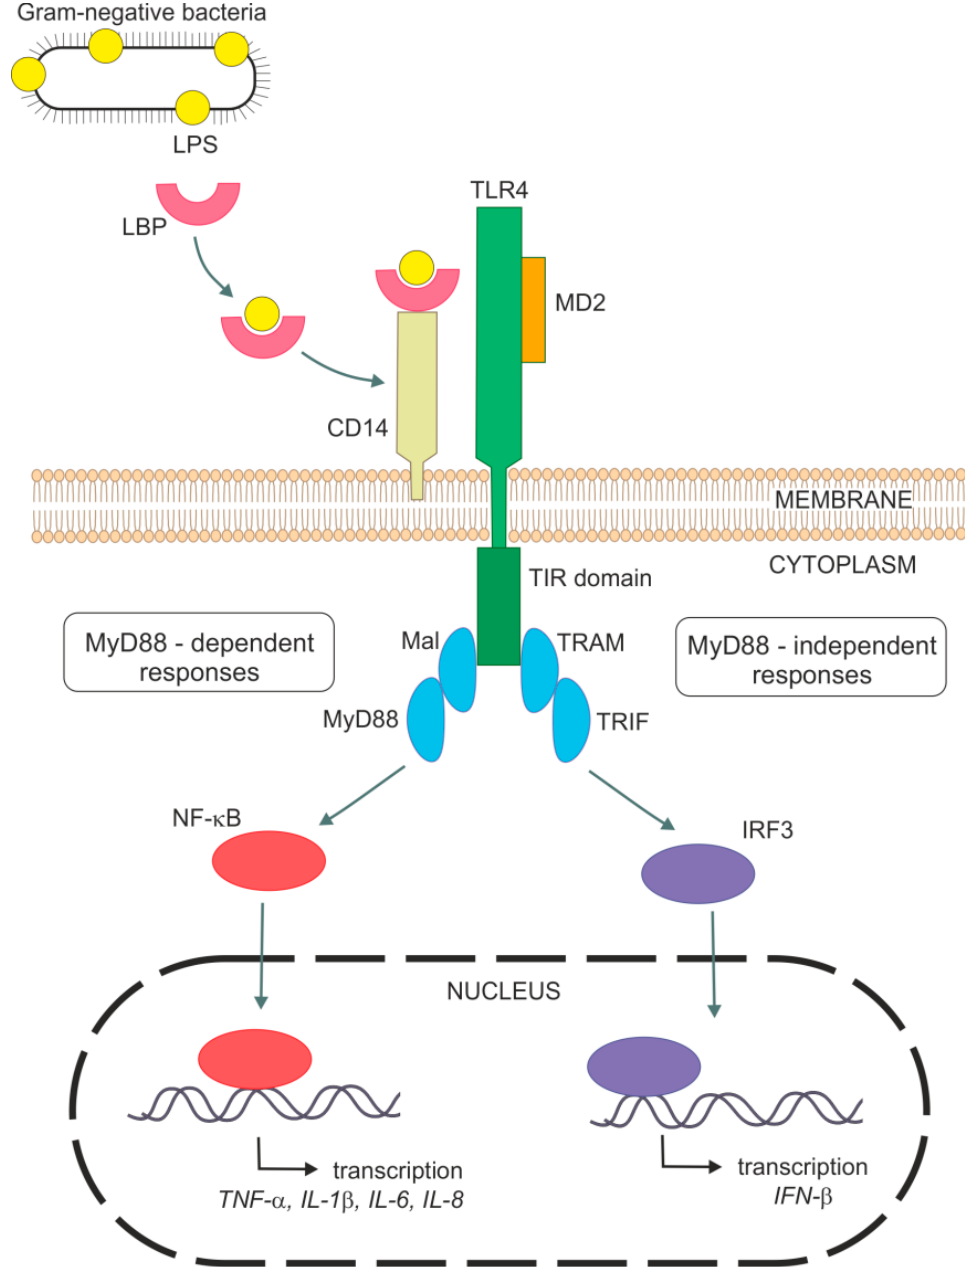
Figure 2. General mechanism of host immune response to Lipopolysaccharide (LPS) through TLR4 signaling. IFN- β — interferon β , IL—interleukin, IRF3—interferon regulatory factor 3, LBP—LPS binding molecule, LPS—lipopolysaccharide, Mal—MyD88 adaptor-like protein, MD2—myeloid differentiation protein 2, MyD88—myeloid differentiation factor 88, TIR domain—Toll/IL-1R